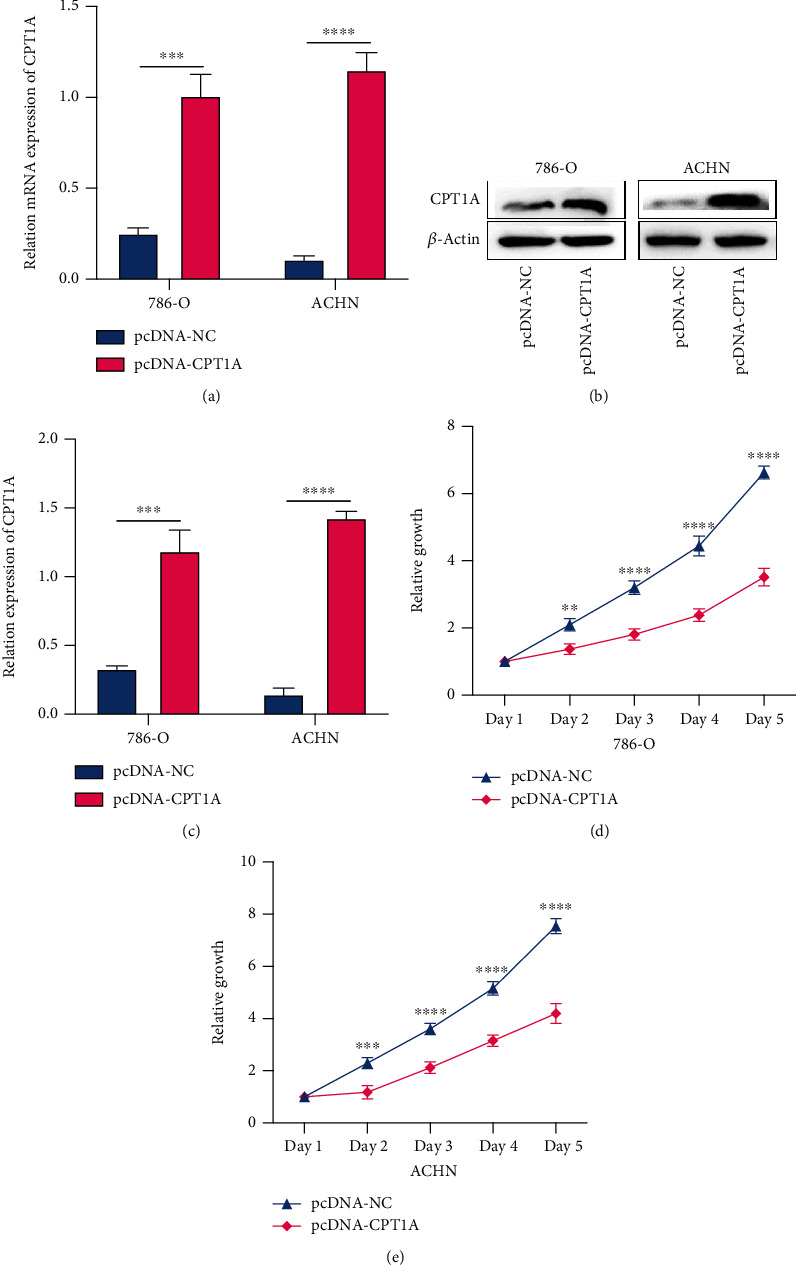
Verification of CPT1A overexpression and cell proliferation experiments. (a) Histogram of qRT-PCR results after plasmid transfection. (b, c) Image and histogram of western blotting results after plasmid transfection. (d, e) The results of CCK-8 experiments in the two cell lines 786-O and ACHN following plasmid transfection. ∗∗P < 0.01; ∗∗∗P < 0.001; ∗∗∗∗P < 0.0001.